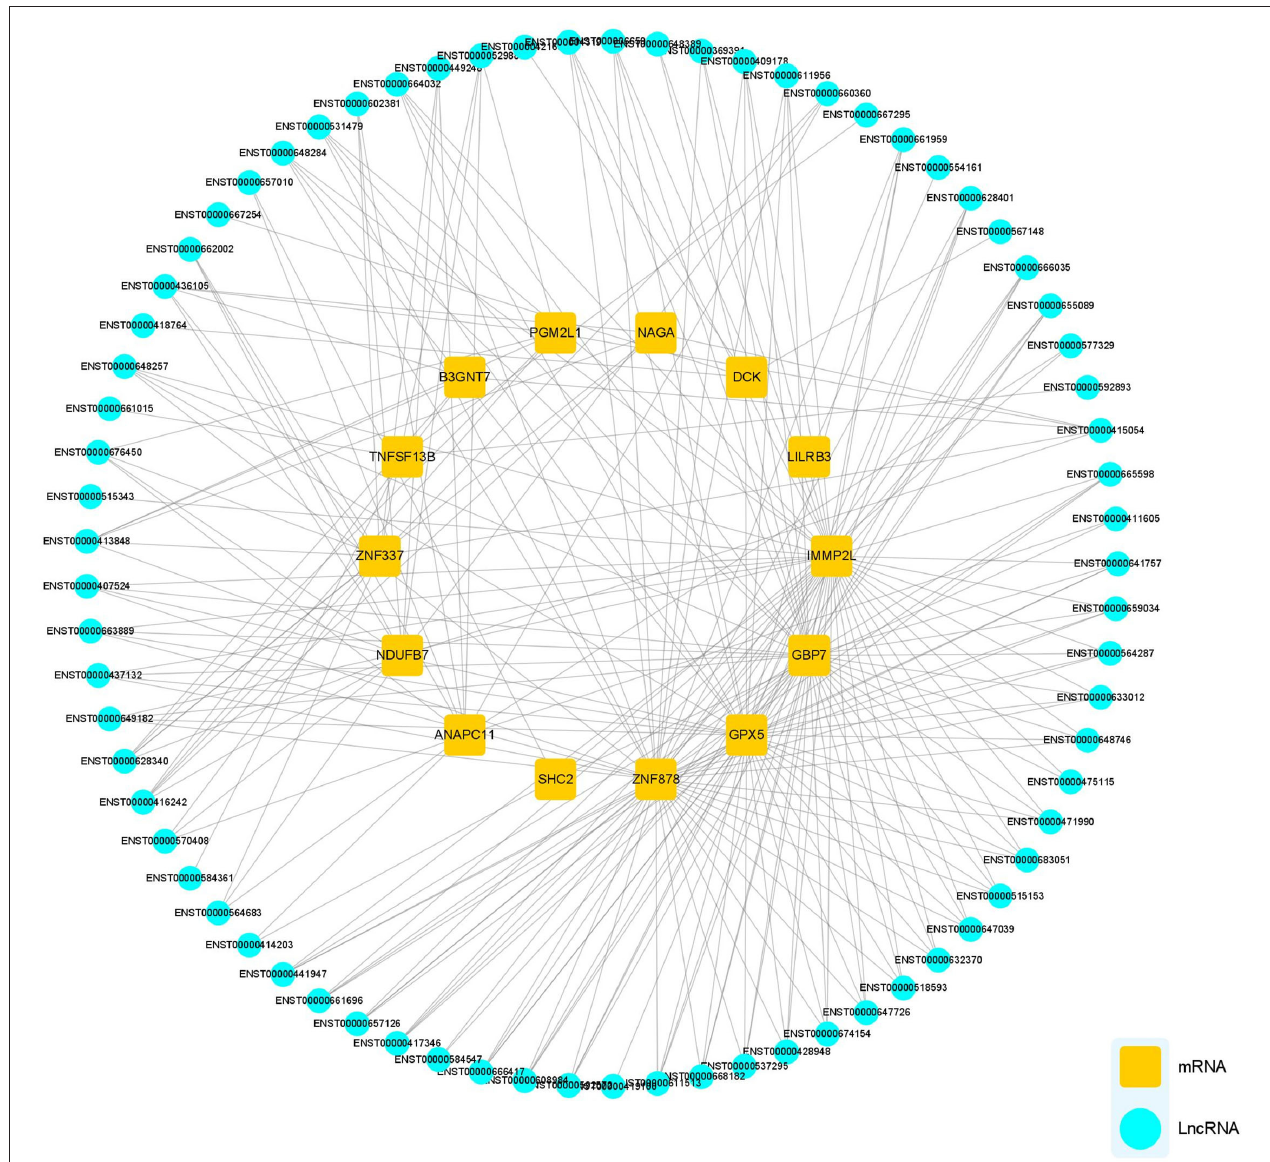
FIGURE 6 | lncRNA-mRNA Co-expression network analysis. lncRNA-mRNA co-expression networks contained 87 nodes, including 73 lncRNAs and 14 mRNA DEmRNAs which were positively related. lncRNAs, long noncoding RNAs; mRNA, messenger RNA; DElncRNAs, differentially expressed lncRNAs; DEmRNAs, differentially expressed